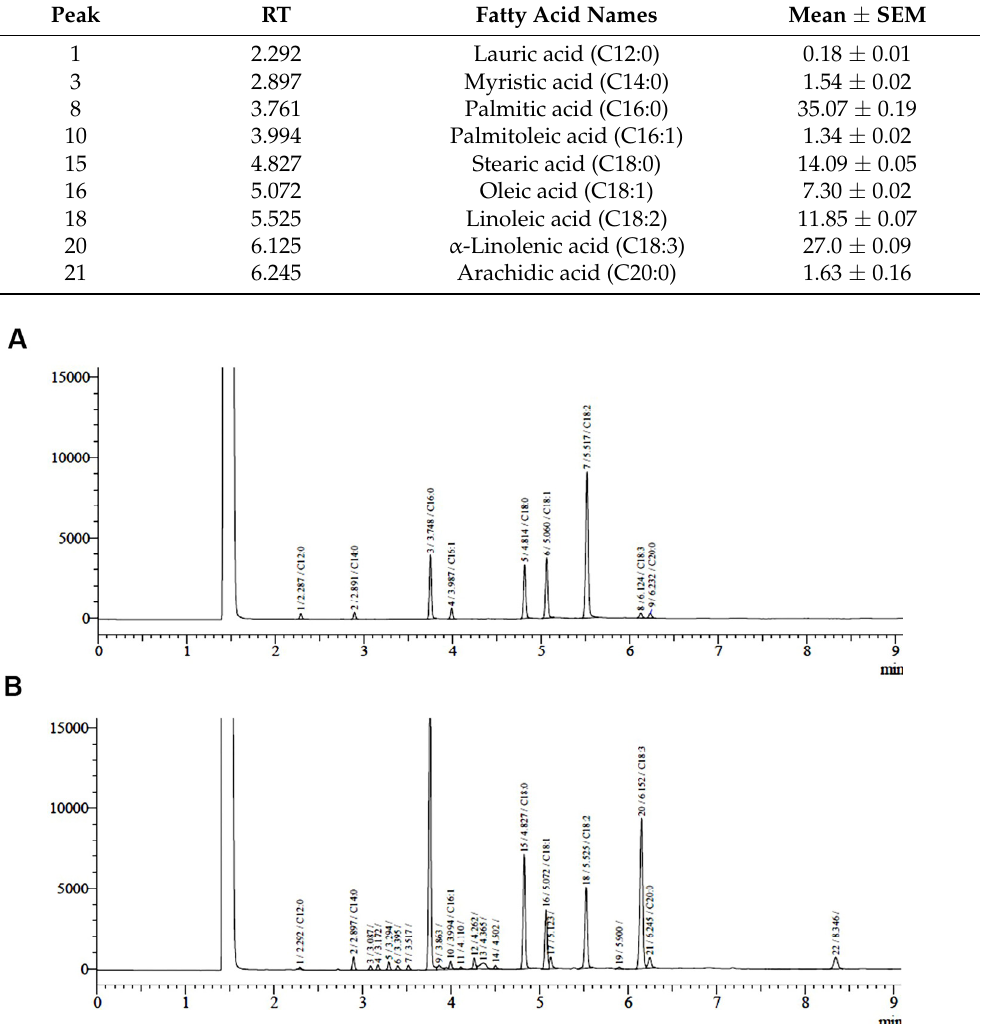
Table 2. The fatty acids identified from the MC stem extracts by GC/FID analysis.